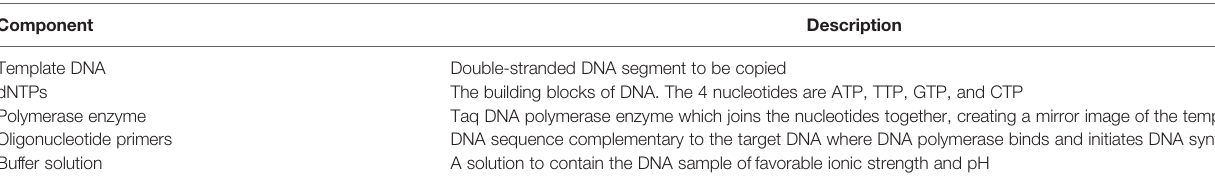
TABLE 6 | Summary of PCR components and description.